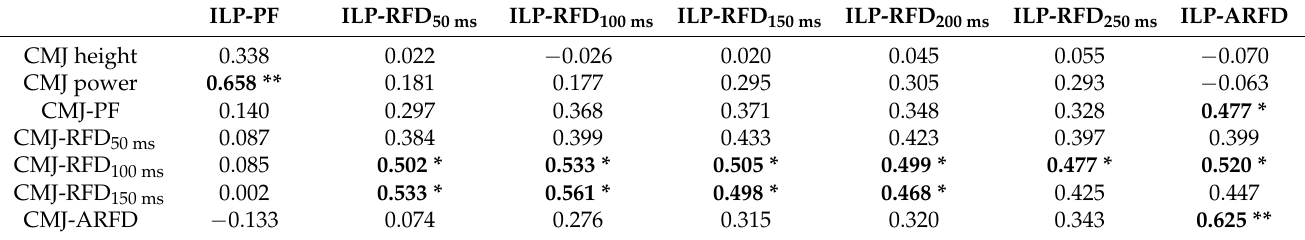
Table 2. Correlation coefficients (Pearson’s r ) between CMJ and ILP force–time characteristics (n = 19). ILP-PF